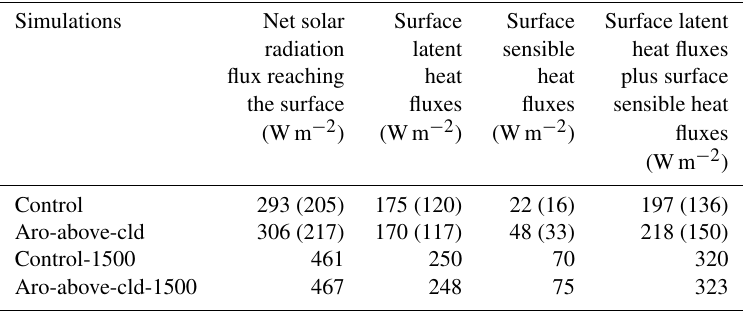
Table 2. The time- and area-averaged net solar radiation, latent heat, sensible heat and total heat (sensible plus latent heat) fluxes at the surface over the whole simulation period in the standard simulations. The numbers in parentheses are averaged over the initial period between 10:00 and 13:50LST for the control and aro-above-cld